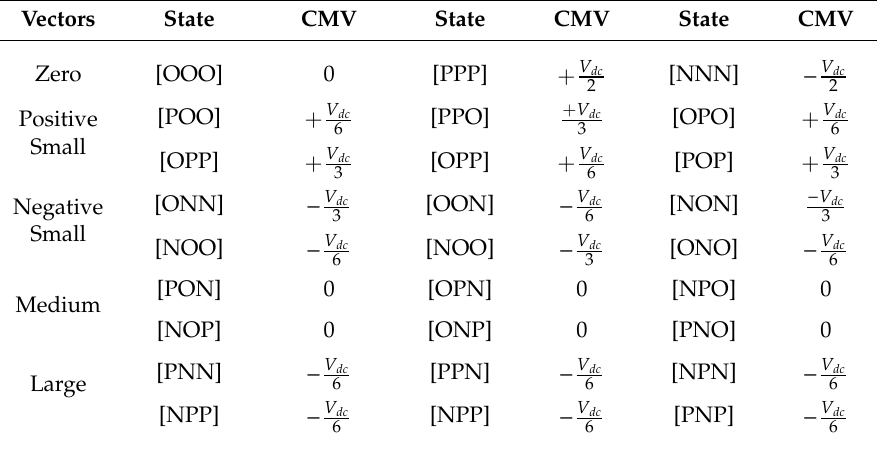
Table 2. CMV generation by Z-source converter.